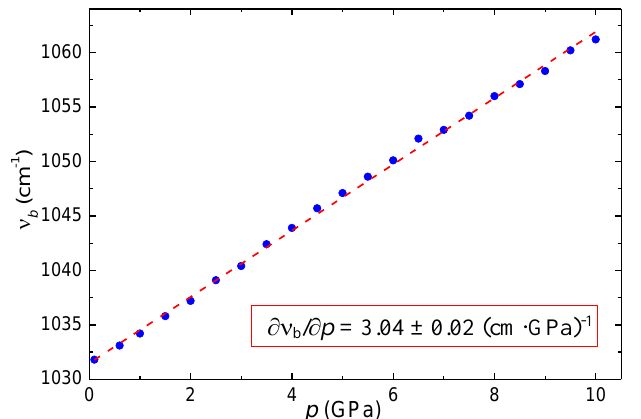
Figure 4. Dependence of the frequency of the vibration mode centered at 1031 cm − 1 at 0.1 GPa from the applied pressure.